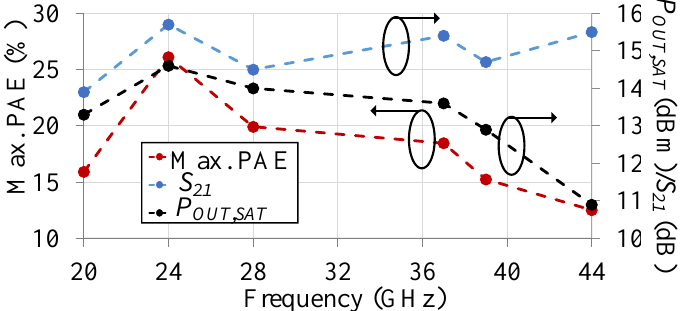
Figure 14. Measured maximum PAE, S 21 , and P OUT,SAT vs. frequency of the broadband CMOS FD-SOI PA.